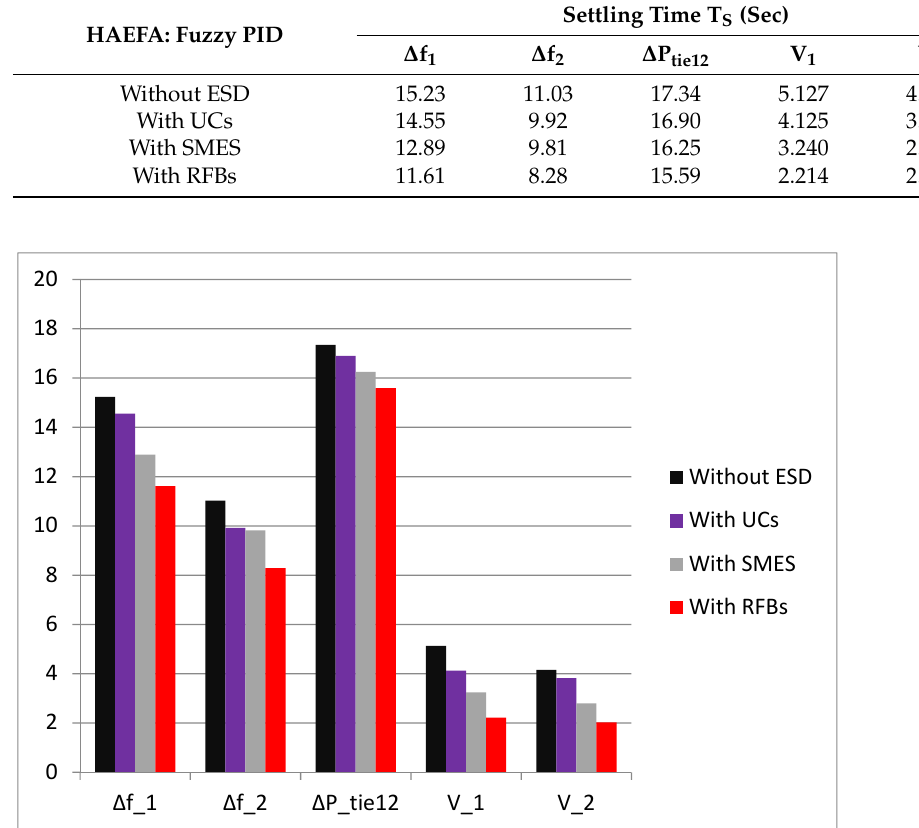
Figure 11. Comparison of responses’ settling time (in seconds on Y-axis) for different ESDs.